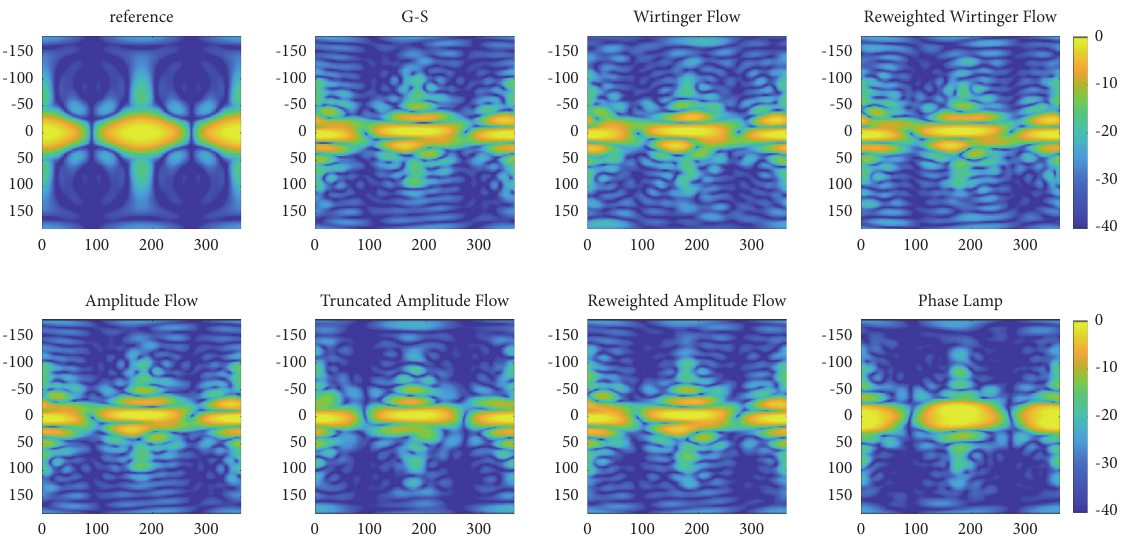
Figure 12: The reconstructed E